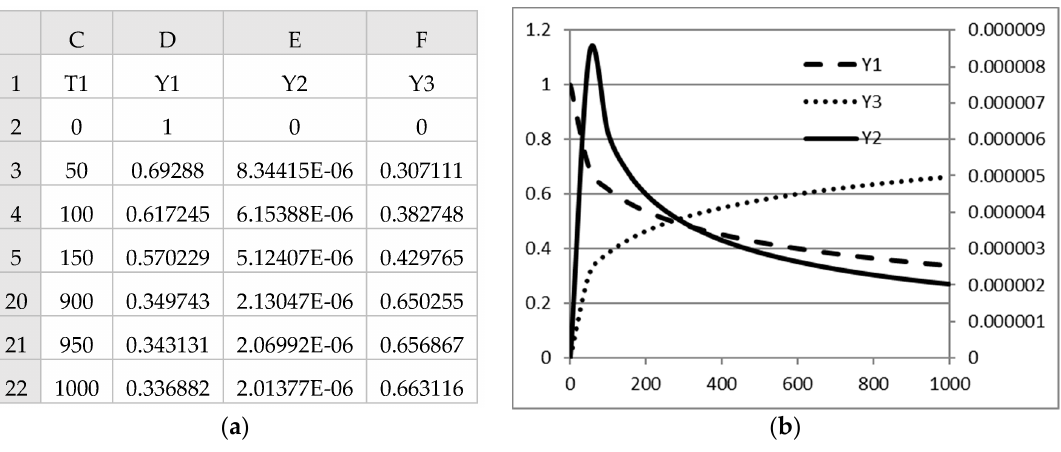
Figure A2. ( a ) Partial listing of the computed solution by formula A3; ( b ) Plots of the trajectories.